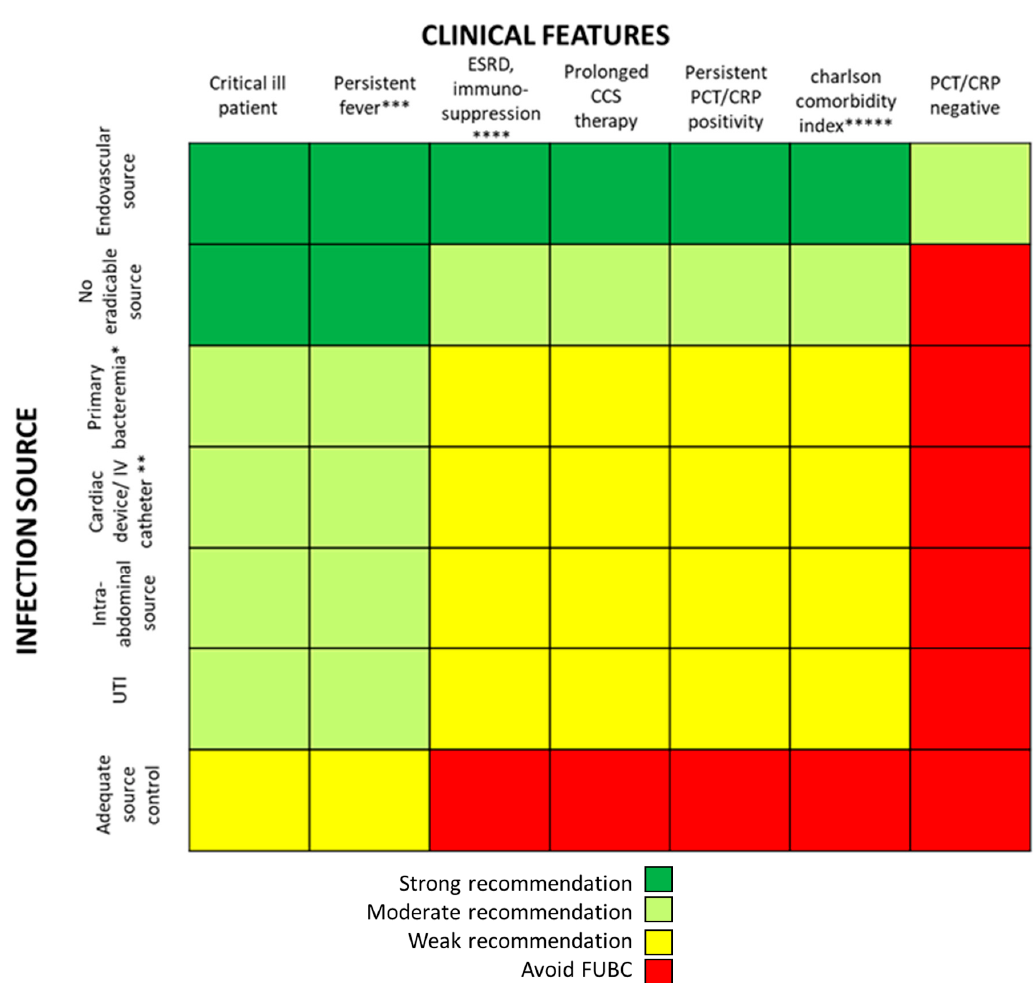
Figure 2. Analysis of recommendations for FUBC sampling in the setting of Gram negative bacteremia